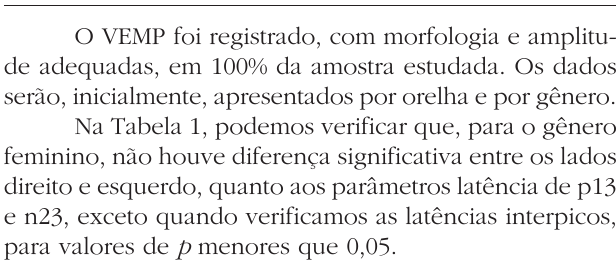
Tabela 3. Valores de latência do VEMP por gênero.